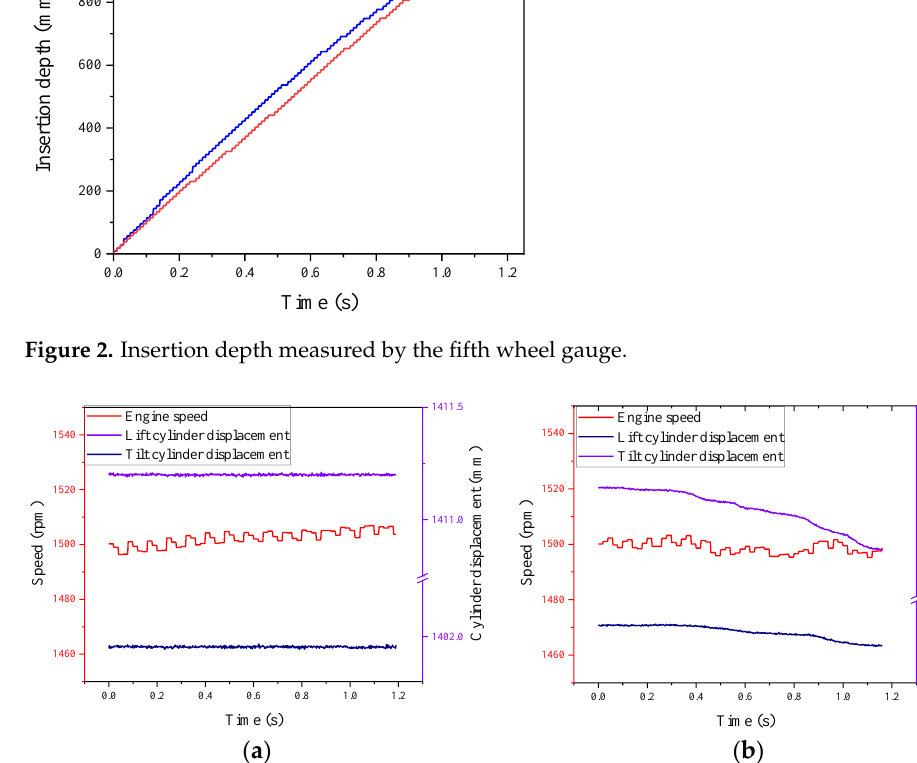
Figure 2. Insertion depth measured by the fifth wheel gauge.